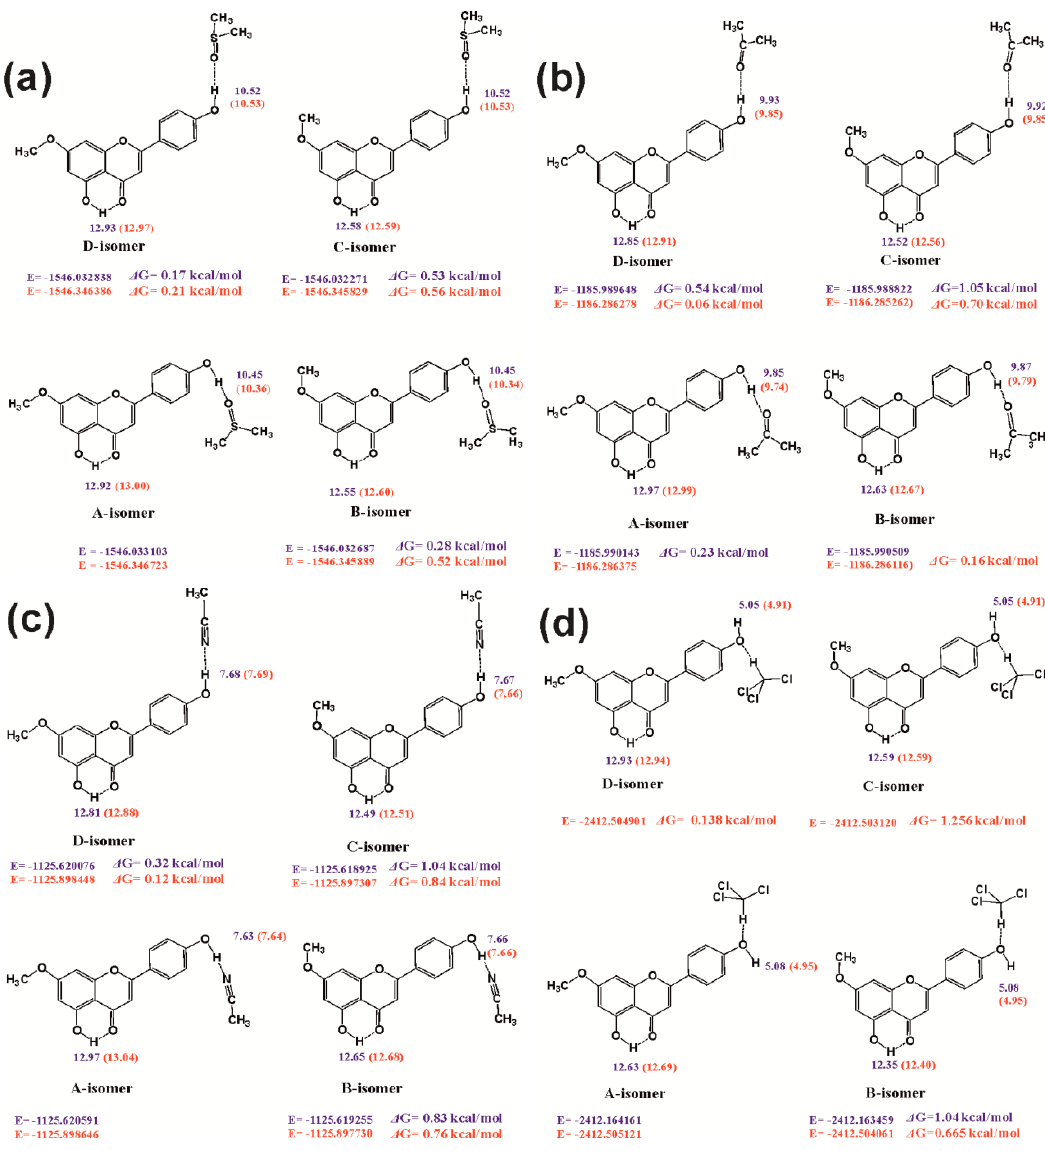
Figure 16. The effect of conformation of the C-7 OCH and C-4 ′ OH groups on the 3 chemical shifts of the C-4 ′ OH and C-5 OH protons for the 1:1 complexes of ( a ) genkwanin + DMSO; ( b ) genkwanin + Me CO; ( c ) genkwanin + MeCN and ( d ) genkwanin + CHCl , 2 3 with the use of DFT/B3LYP/6-31+G( d ) (data in blue) and DFT/B3LYP/6-311++G(d,p) (data in red) level of theory. Reprinted with permission from [41]. Copyright 2013, The Royal Society of